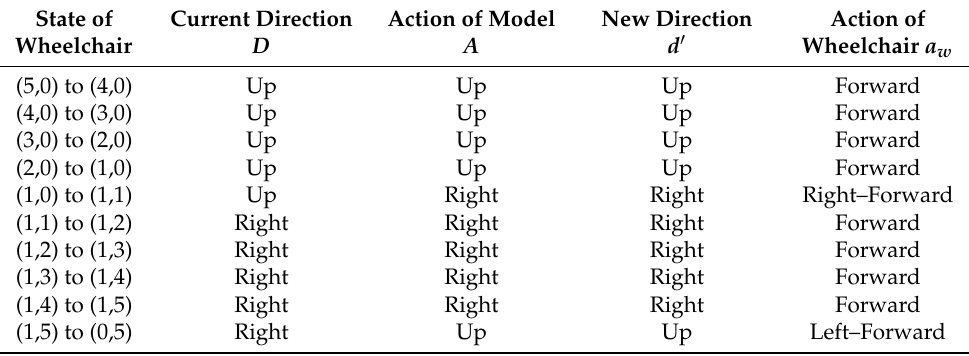
Table 4. Wheelchair Control Commands Converted from Simulation Commands.